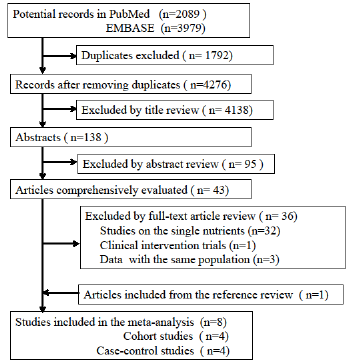
Figure 1. Flow chart of literature search.